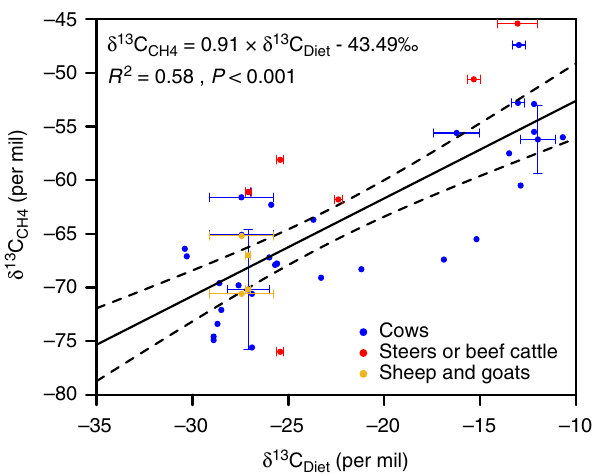
Fig. 2 Linear regression between δ 13 C of diet ( δ 13 C diet ) and δ 13 C of CH 4 from enteric fermentation of ruminants ( δ 13 C CH4-ruminant ). The dots denote